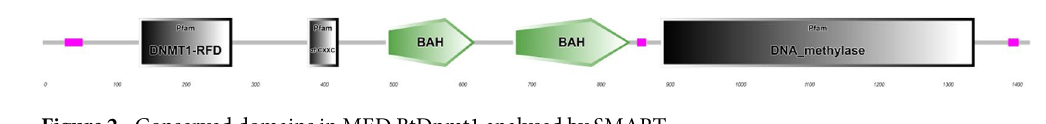
Figure 2. Conserved domains in MED BtDnmt1 analysed by